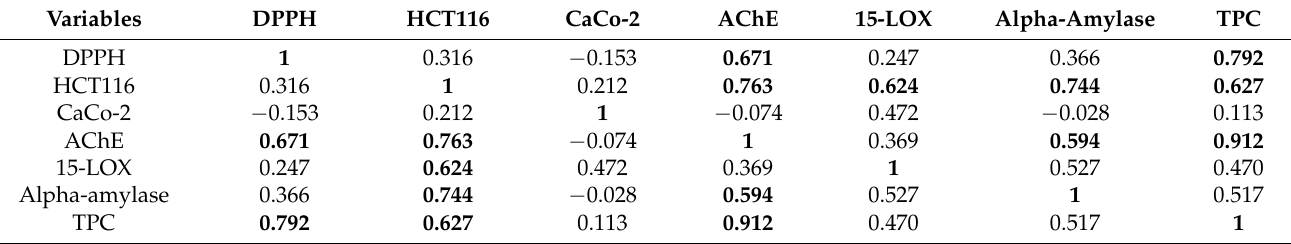
Figure 7. Anti-Alzheimer activity of different extracts of V. vinifera stem (CYHA: Cyclohexane; DCM: Dichloromethane; EtOAc: Ethyl acetate; MeOH: Methanol; GaHbr: Galantamine Hydrobromide used as reference at 1.5 µg/mL). Extracts were tested at 50 µg/mL Means values ± SD ( n = 3); Different letter on the histograms means a significant difference ( p ≤ 0.05). Table 6. Correlation matrix (Pearson ( n )).